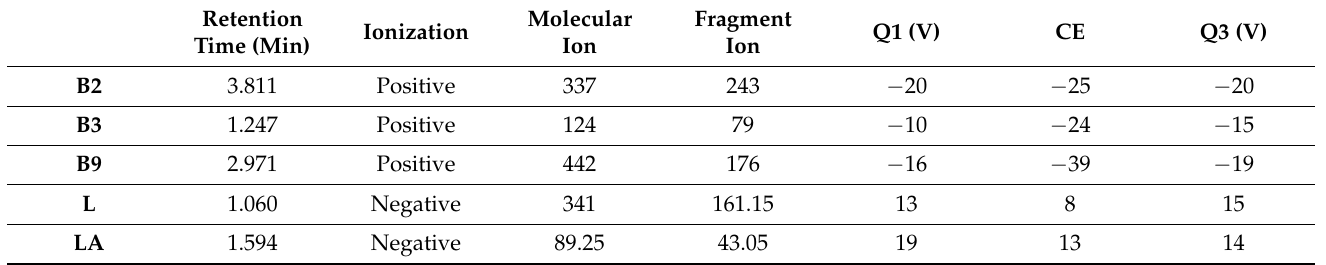
Table 1. Conditions for the detection of the analyzed compounds. B2—riboflavin; B3—niacin; B9—folic acid; L—lactose; LA—lactic acid.